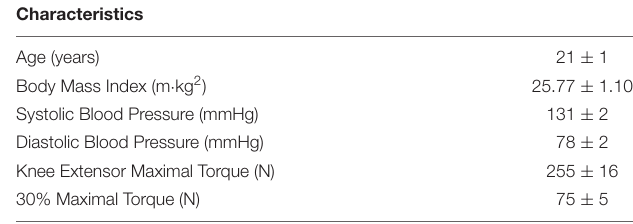
TABLE 1 | Participant characteristics ( n =